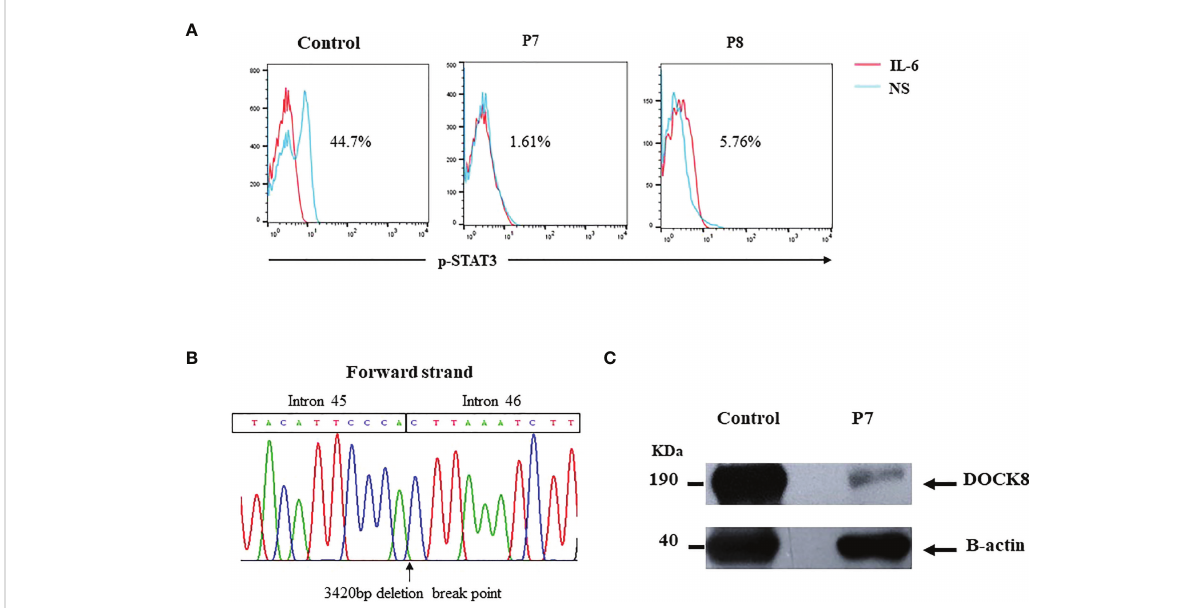
FIGURE 4 (A) Defective STAT3 phosphorylation in DOCK8 de fi cient patients (B) DOCK8 Ex46 deletion in P7. Chromatogram showing the 3420bp deletion breakpoint in the patient ’ s genomic DNA (C) DOCK8 protein expression in P7 showing residual expression.